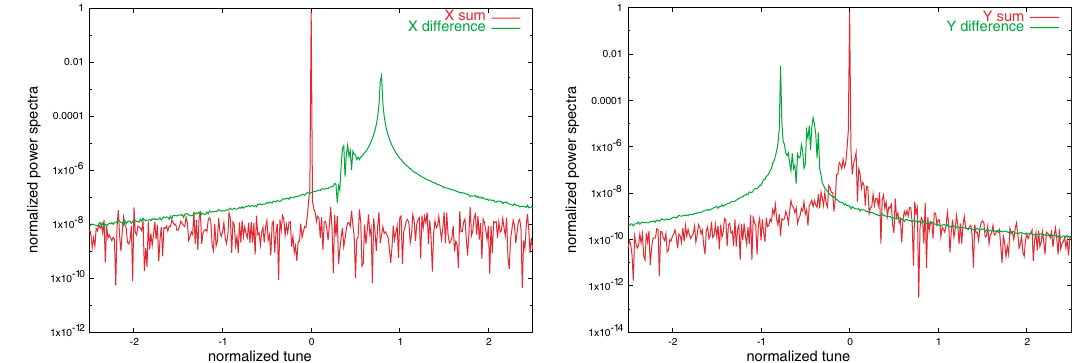
FIG. 5. (Color) Spectra of the horizontal (left panel) and vertical (right panel) sum and difference centroid motion for long-range horizontal beam-beam collision with 9 (cid:8) x